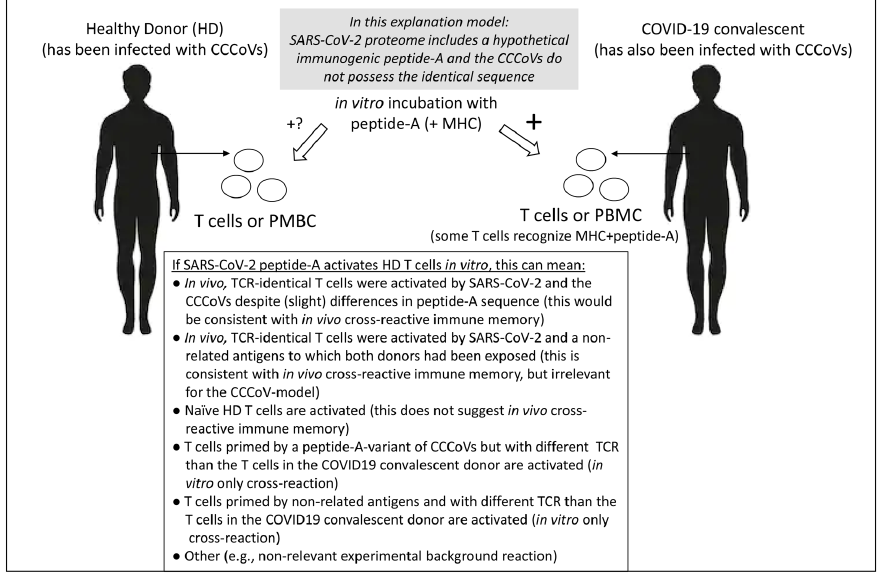
Figure 2. Theoretical possibilities for explaining in vitro activation of T cells from healthy donors (HD) by a hypothetical immunogenic SARS-CoV-2 peptide (“peptide-A”) that has no perfect sequence match in the CCCoVs. Even if the CCCoVs do possess a very similar sequence, the in vitro activation does not need to be indicative for peptide-A being an epitope for in vivo cross-virus T cell memory. In the model, peptide-A is either used directly or as part of pMHC complexes, and the T cells are stimulated after their isolation or as part of PBMC.